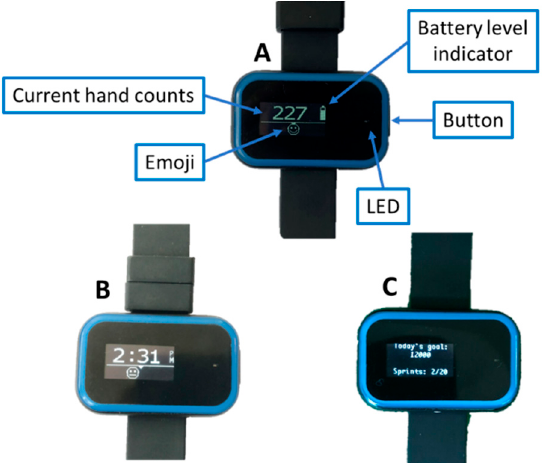
Figure 3. Manumeter screens shown to the participants in the feedback group. The counts screen ( A ) showed their current number of hand movement performed during the day, battery indicator, and